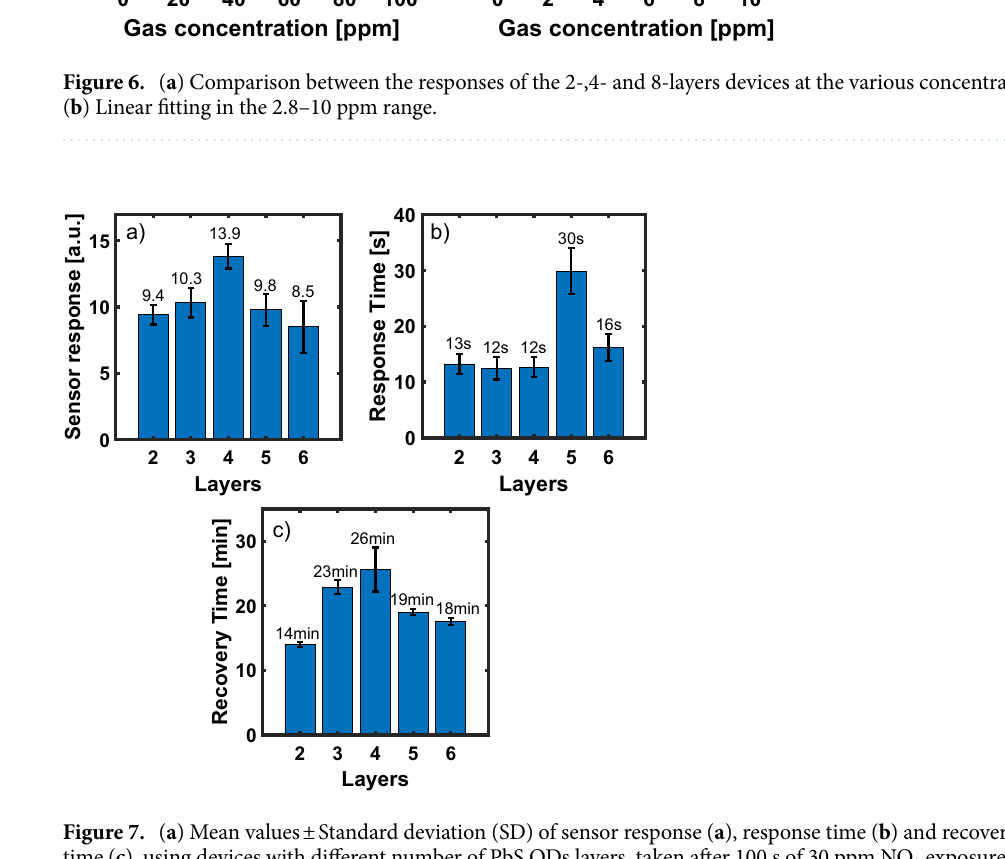
Figure 7. ( a ) Mean values ± Standard deviation (SD) of sensor response ( a ), response time ( b ) and recovery time ( c ), using devices with different number of PbS QDs layers, taken after 100 s of 30 ppm NO 2 exposure at room